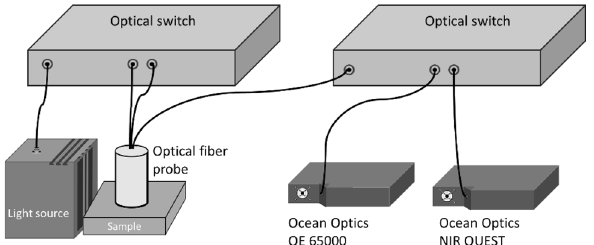
Figure 8. Schematic diagram of the DRS system setup employed in this study. Two optical switches were used in the system where one was used for switching light source to one of the source fibers to deliver light to